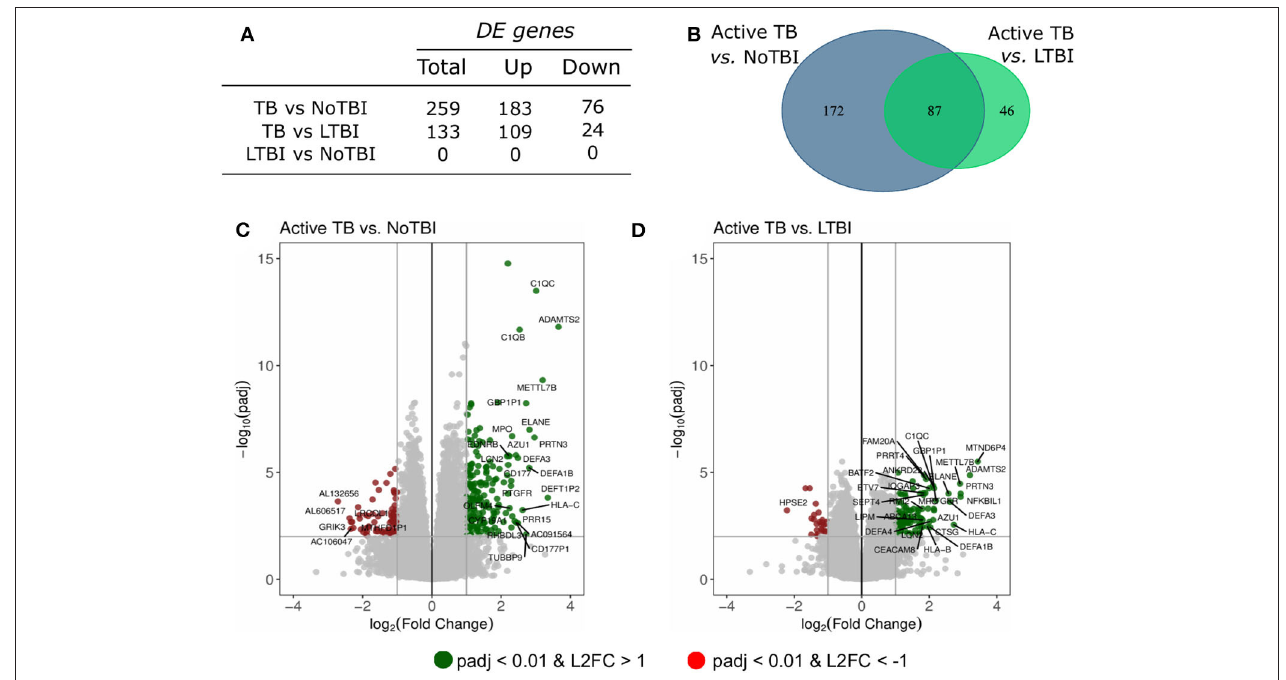
FIGURE 1 | Summary of the differentially expressed (DE) genes in the pairwise contrasts comparing the TB study groups. (A) Total number of DE genes (adjusted p < 0.01 and absolute Log2 Fold Change (L2FC) > 1) and number of up- or down-regulated genes. (B) Venn diagram with the overlapping genes between the different signatures. The volcano plots highlight the genes with significant differences between (C) active TB patients vs. uninfected (NoTBI) contacts and (D) active TB patients vs. contacts with latent infection (LTBI). The Top-30 most modulated (genes with the greatest absolute fold change) genes were